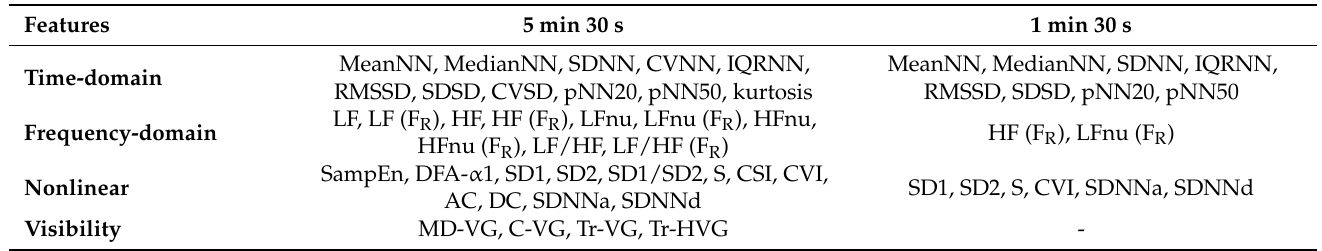
Table 4. HRV features showing good agreement between PPG and ECG recordings. All features have strong correlation coefficients (>0.7), negligible Cliff’s delta ( δ < 0.11), and statistical equivalence ( p -value <